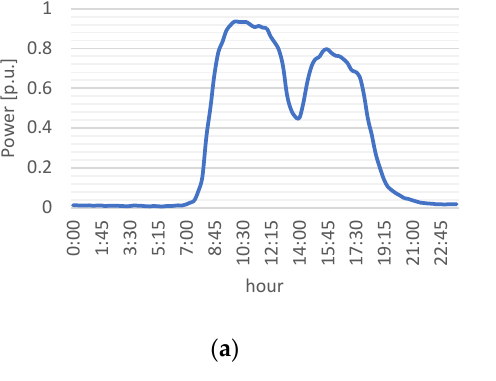
( b ) Figure 6. “Mount-type profile” obtained in industrial clients I2 (L) and commercial clients C1 and C2 (L-S-D). ( a ) The left curve corresponds to an industrial customer, and ( b ) the right curve corre- sponds to a commercial customer. ( a ) ( b ) Figure 7. “U-type profile” obtained in industrial clients I1 and I2 (L-S-D) and commercial clients C1 and C2 (L-S-D). ( a ) The left curve corresponds to an industrial customer, and ( b ) the right curve corresponds to a commercial customer.